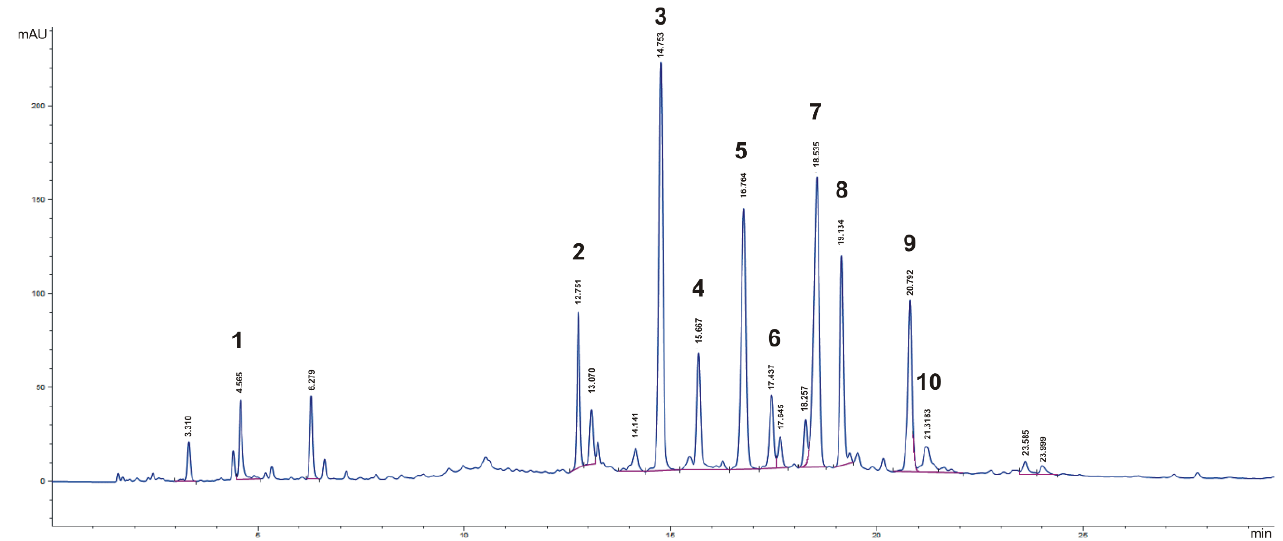
Figure 1. HPLC–DAD chromatogram of myrtle berry extract at λ = 280 nm. Chromatographic conditions are described in the text. 1: Gallic acid; 2: Gallic acid derivative; 3: Delphinidin-3- O -glucoside; 4: Cyanidin-3- O -glucoside; 5: Petunidin-3- O -glucoside; 6: Peonidin-3- O -glucoside; 7: Malvidin-3- O -glucoside; 8: Myricetin-3- O -galactoside; 9: Myricetin-3- O -rhamnoside; 10: Ellagic acid. Table 2. Characteristics of empty and myrtle liposomes: mean diameter (MD), polydispersity index (PI), and zeta potential (ZP). Each value represents the mean ± SD ( n > 10). ** Values statistically different ( p < 0.01) from empty liposomes.